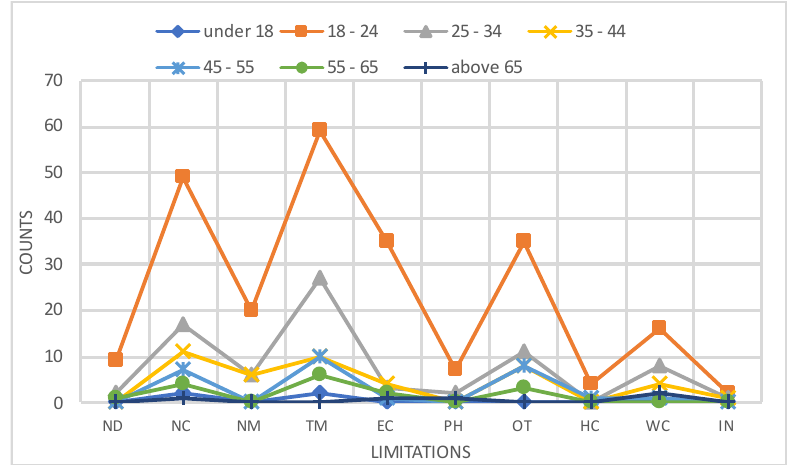
Figure 23. A graph of interaction between limitations in terms of bus availability and the age of the respondent.